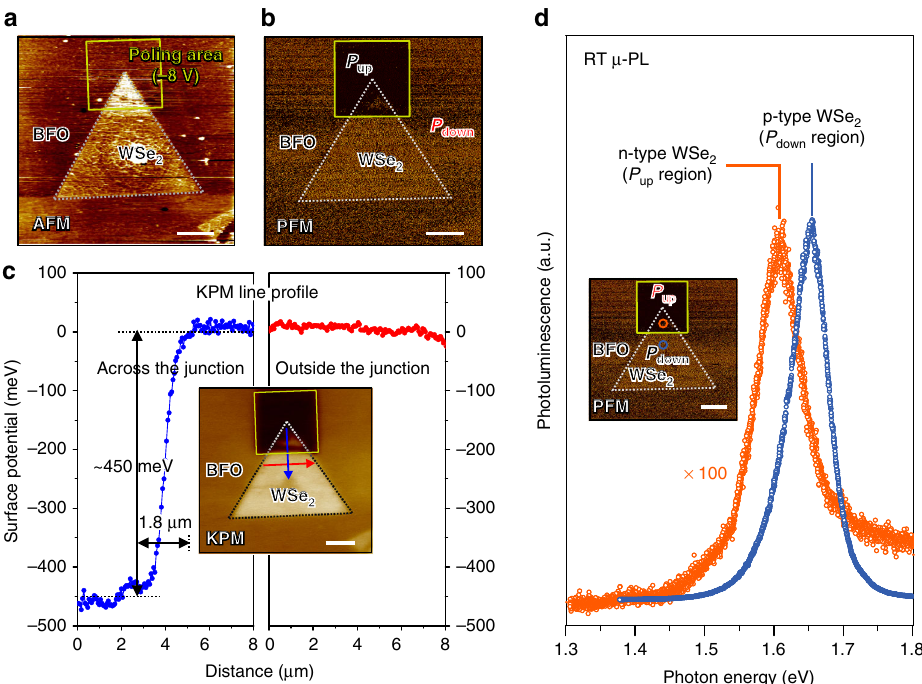
Fig. 2 The scanning probe microscope images and μ -PL spectra of the WSe 2 pn homojunction. WSe 2 on P up and P down regions from measurements with an AFM and PL. a , b AFM and PFM taken of a WSe 2 sheet on the BFO ferroelectric layer as grown. The solid line shows poled regions with bias − 8 V at an AFM tip (yellow lines). A PFM image taken of a WSe 2 sheet on a BFO layer with P up and P down regions, which shows the out-of-plane ferroelectric polarization in BFO to have phase difference 180°. c KPM image and line pro fi le image taken across and outside the P up and P down homojunction. d PL of a WSe 2 sheet taken from the P up and P down homojunction. The scale bars in the fi gures are 5 μ